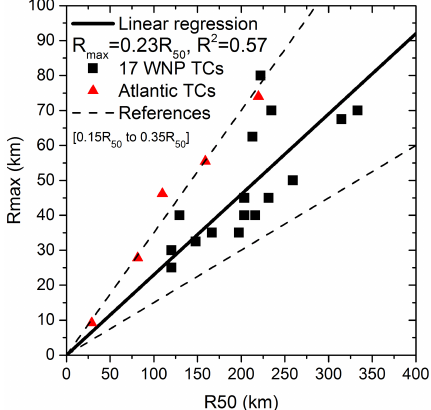
Figure 6. Relationship between the radii of the 50kt winds around a typhoon ( R 50 ) and the maximum wind radius ( R max ). The two bro- ken lines indicate the range in which 95% of the plots fall (i.e., 95% prediction interval). The Atlantic TC plot is derived from Kimball et al.